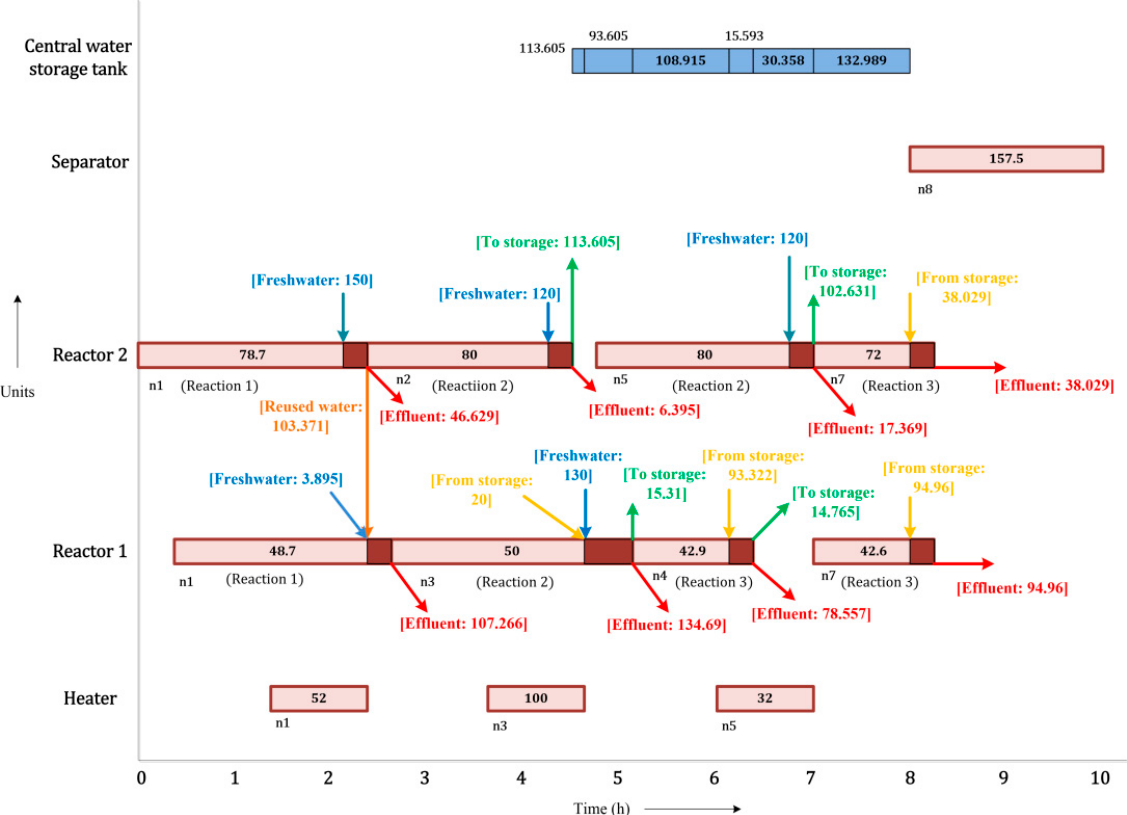
Figure 12. Gantt chart obtained for the simultaneous approach for case study 3 with water storage tank.